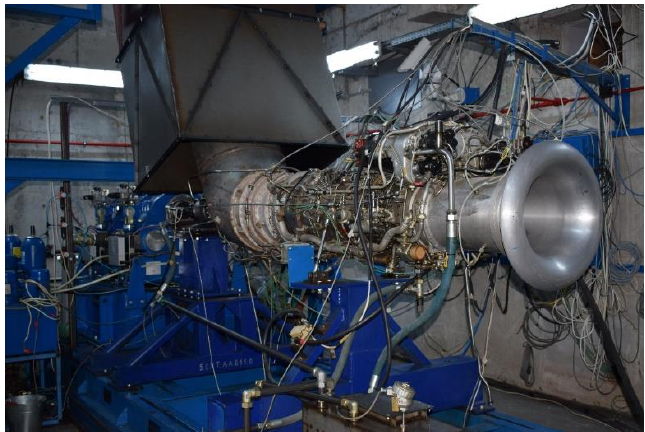
Figure 7. TV2-117A installed on test bench.